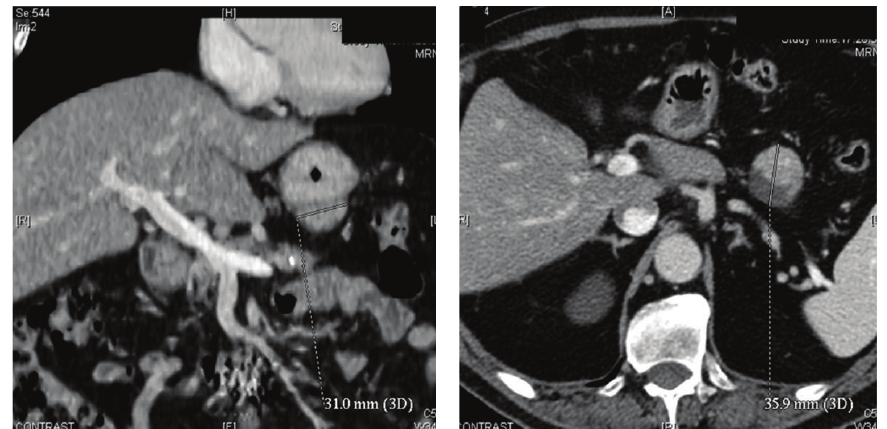
Figure 2: Abdominal CT scan documenting a 3.6 cm GIST of the stomach.